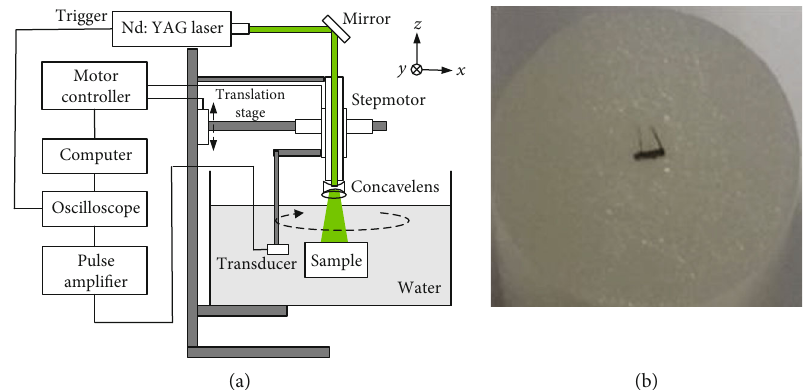
Figure 7: (a) The schematic diagram of PAI imaging system. (b) A photograph of the imaging sample.